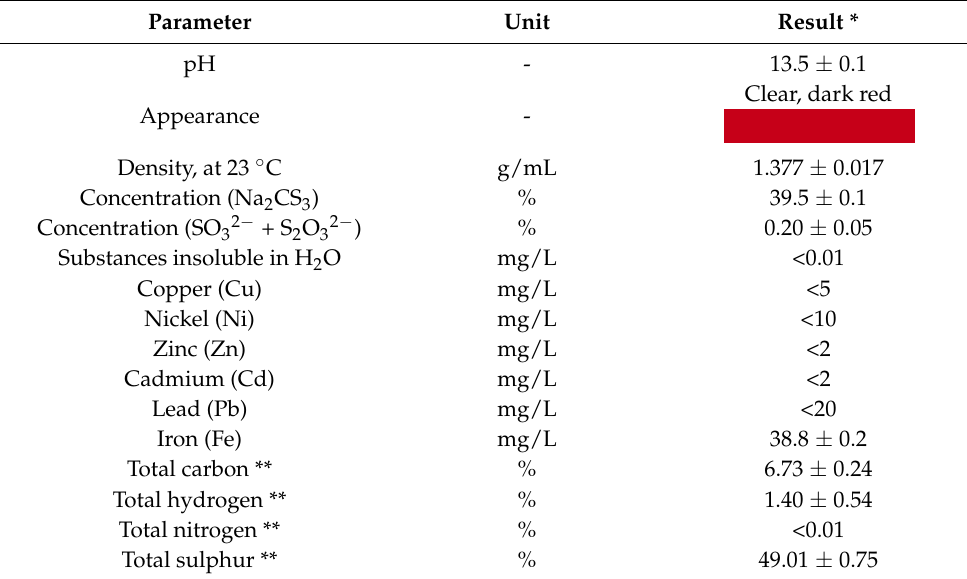
Table 1. Selected physicochemical parameters of the solution of sodium trithiocarbonate (Na 2 CS 3 ).